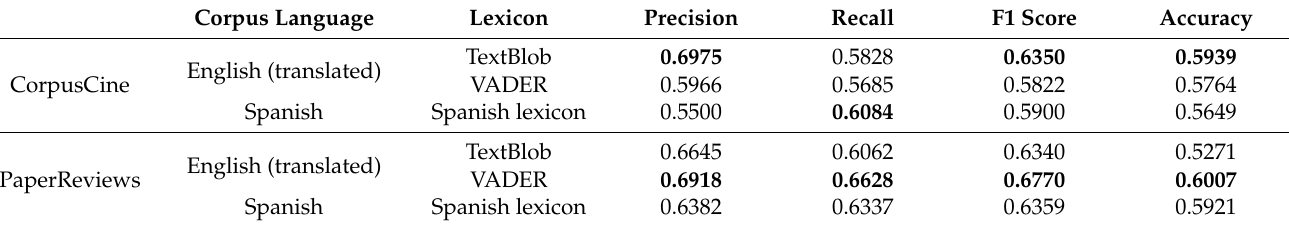
Table 5. Performance of lexicon-based approaches for CorpusCine and PaperReview datasets and their machine-translated English versions. For the Spanish lexicon, we use the available in https: //www.kaggle.com/general/88685 (accessed on 21 March 2021). The best performance is highlighted in